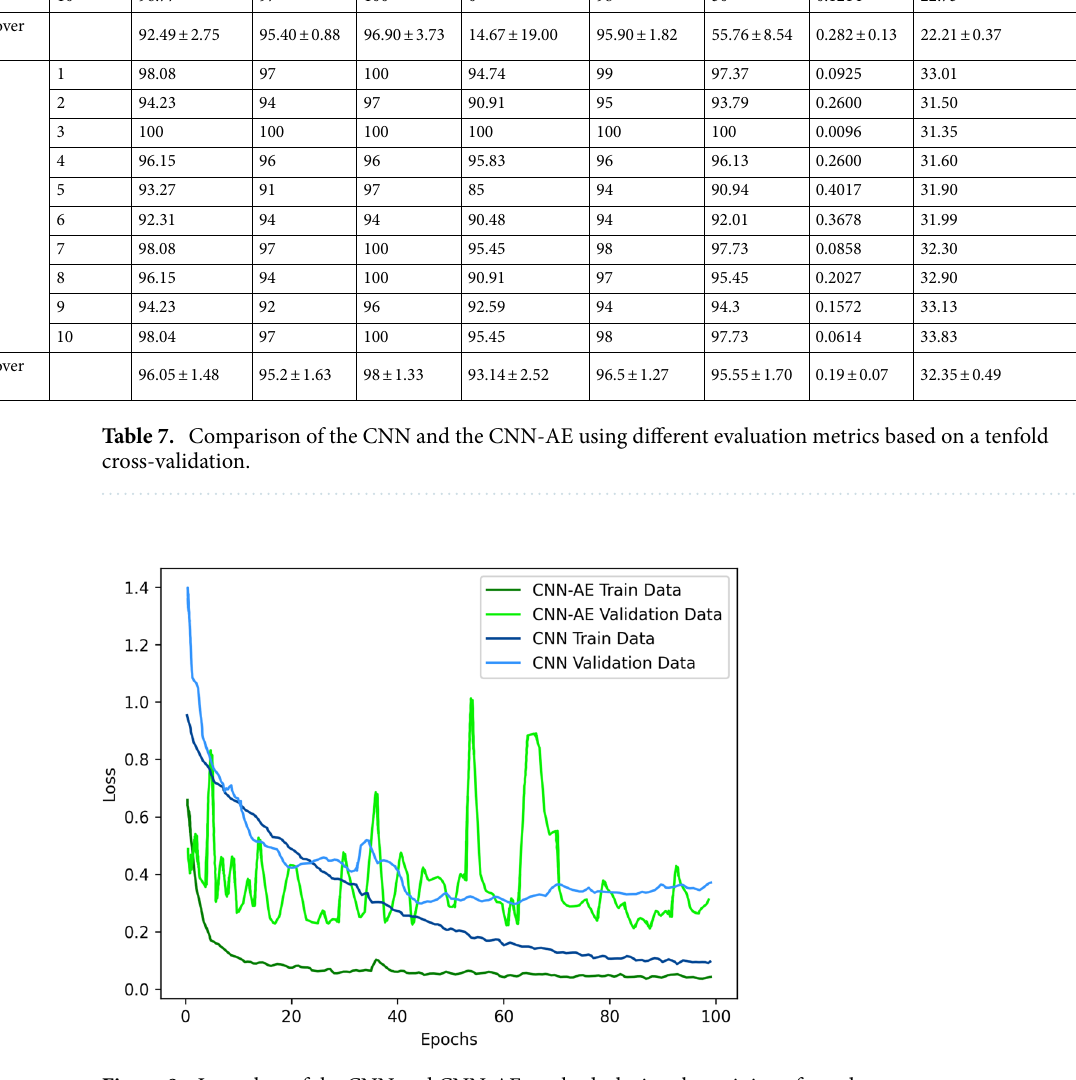
Figure 9. Loss plots of the CNN and CNN-AE methods during the training of our